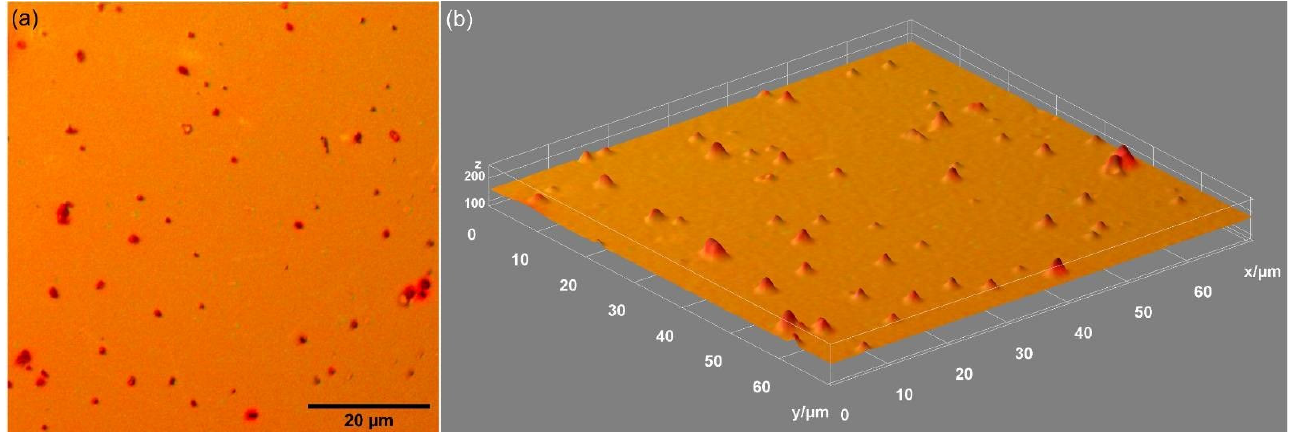
Figure 5. The 2D ( a ) and 3D ( b ) MM images obtained for PANI-IO thin films (20× objective).